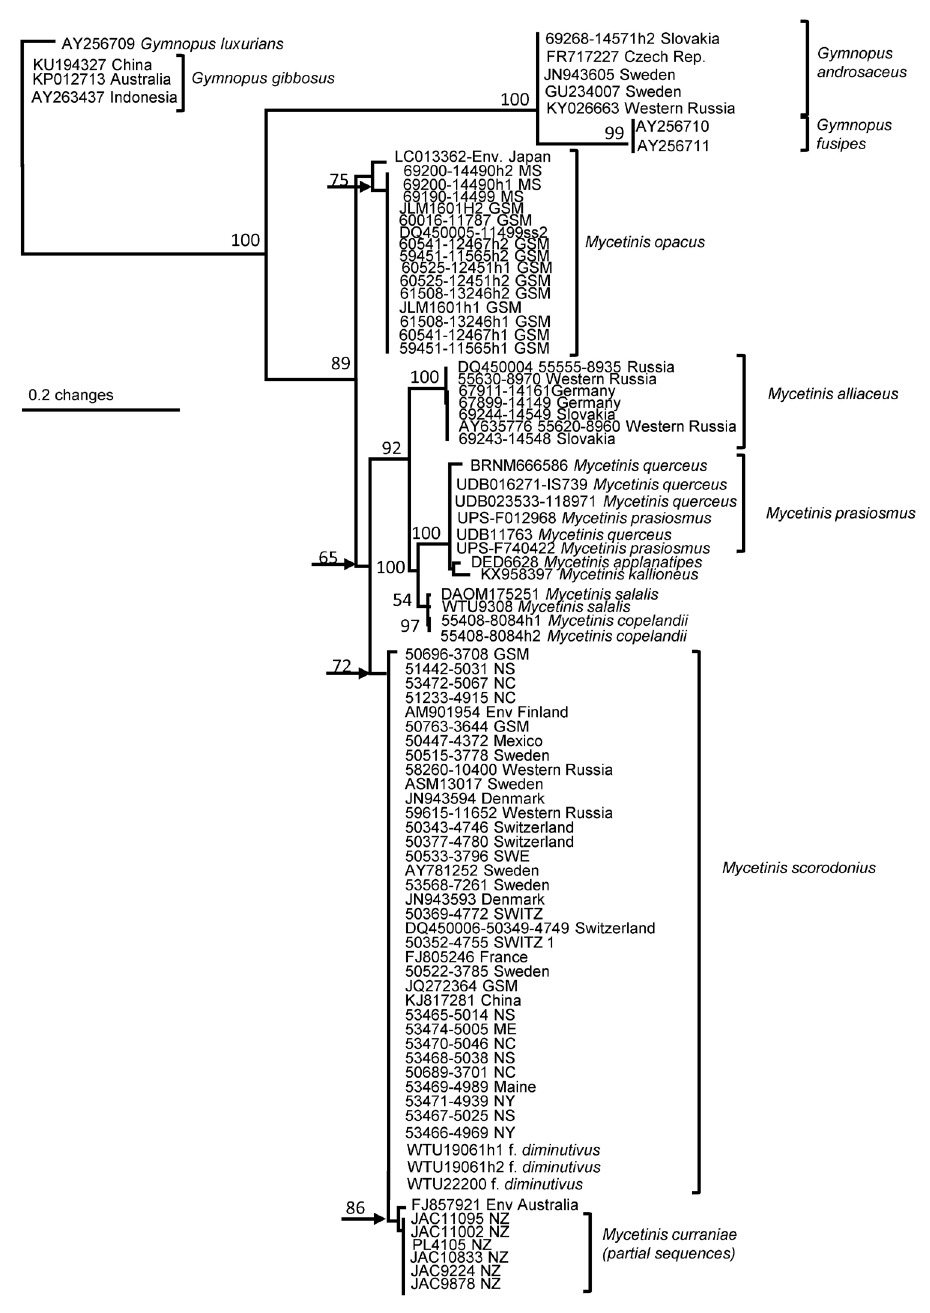
Figure 2. PhyML analysis of Mycetini s showing its relationship to Gymnopus